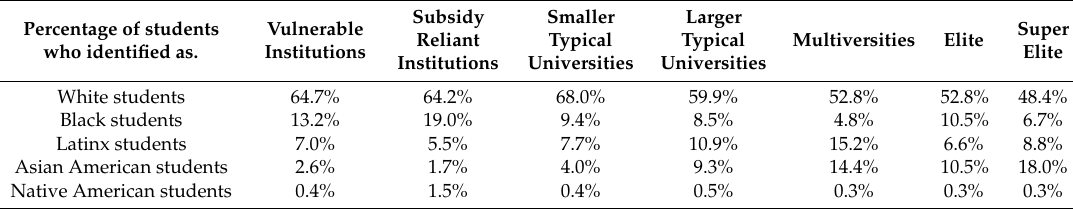
Table 3. Racial demographics of profiles providing low and average value